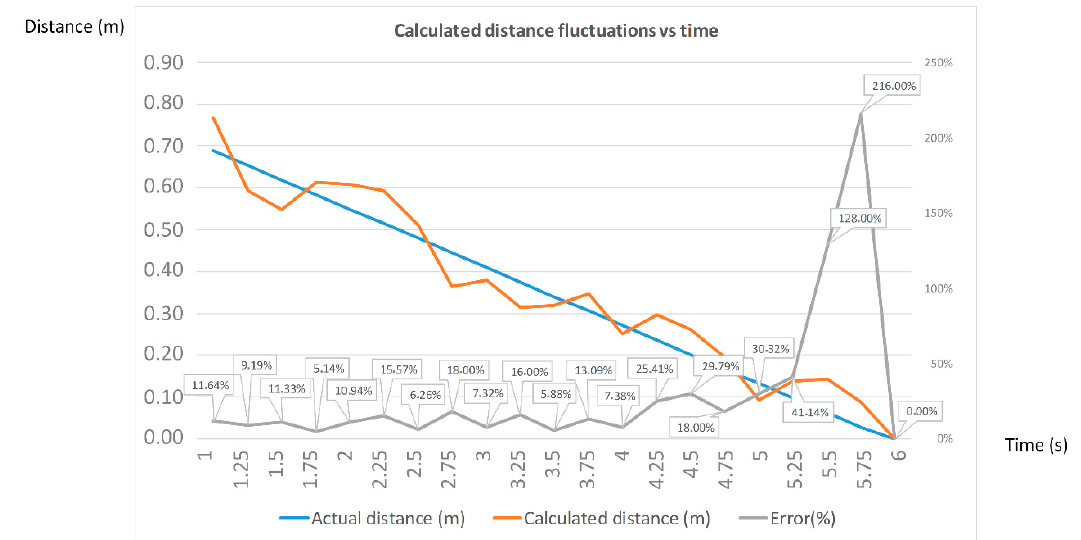
Figure 17. Calculated distance fluctuation for a single tag.